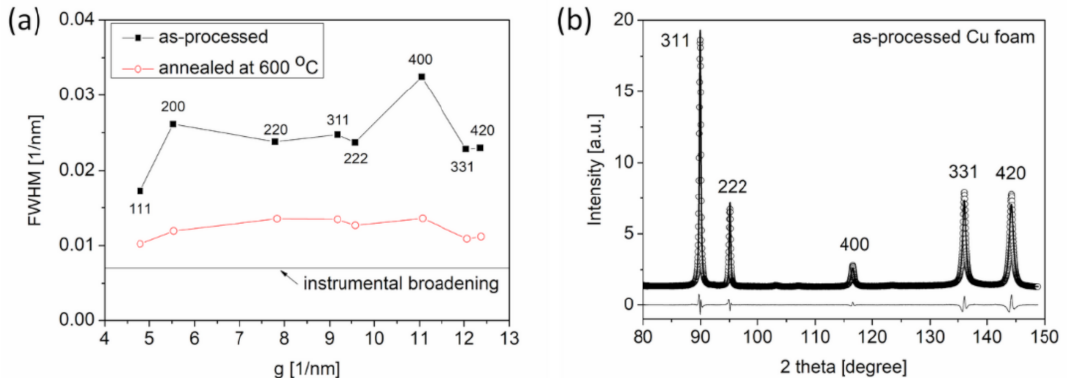
Figure 5. ( a ) Williamson–Hall plots for Cu foam processed by route C and the counterpart of this material, which was annealed at 600 ◦ C for 5.5 h after dealloying. FWHM: full width at half maximum, g: magnitude of the diffraction vector (see text). ( b ) A section of the diffraction pattern evaluated by the CMWP fitting method using data obtained from a Cu foam processed by route C. The open circles represent the measured data, and the solid line reflects the fitted pattern. The difference between the data and the calculated pattern is shown as a black line at the bottom of the figure.